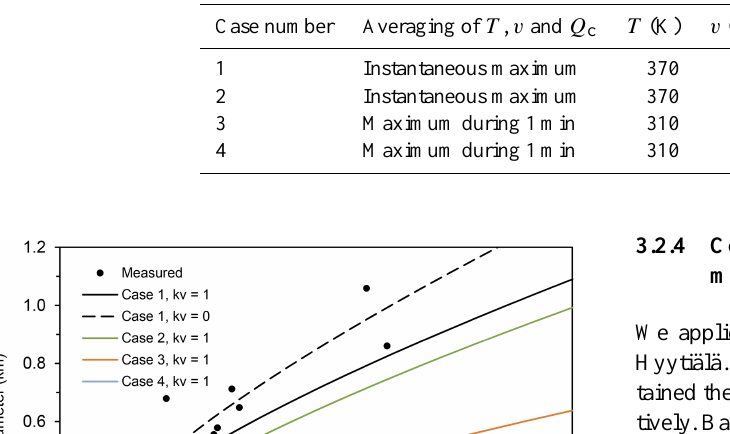
Table 1. The definition of the example cases selected for the prescribed burning experiment in Hyytiälä, and the computed convective heat fluxes ( Q c ) for these cases. The computations were performed for the measured maximum values and for measured maximum values during 1min for the fire temperatures ( T ) and the measured vertical flow velocities ( v) . For each averaging option, two alternative values were assumed for the measured active fire source areas ( A) .